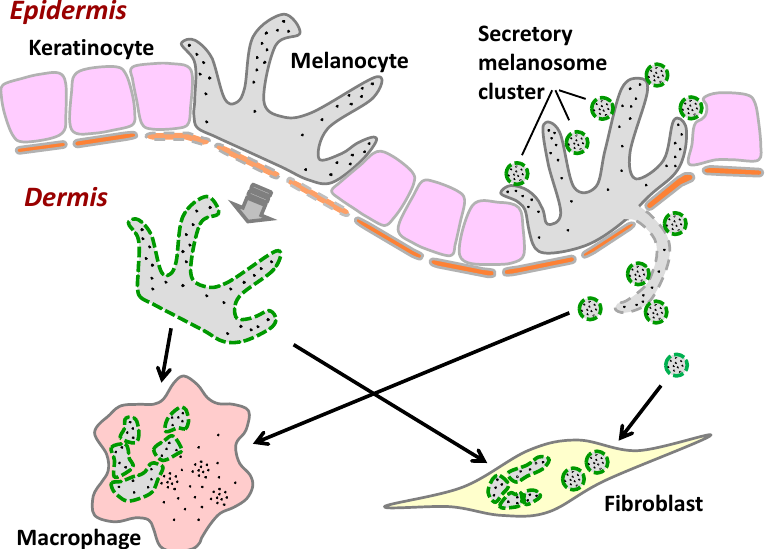
Figure 5. Hypothetical scheme of the internalization of secreted melanosome clusters and apoptotic melanocytes by macrophages and fibroblasts. When melanosomes or melanocytes drop down into the dermis in cases when the basement membrane is disrupted or disappears in abnormal conditions such as excessive inflammation, the secreted melanosome clusters and apoptotic melanocytes might be incorporated not only in macrophages, but also in fibroblasts. Green dashed lines indicate exposed